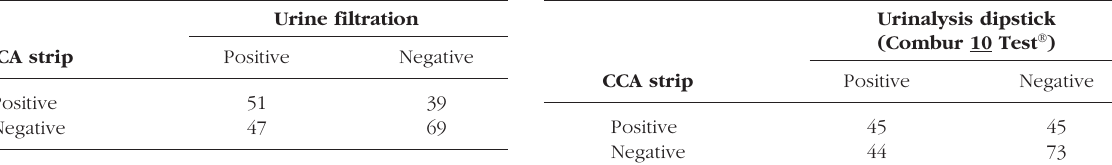
Table II. – Diagnostic performance of CCA strip compared with urine filtration for the diagnosis of urinary schistosomiasis in Hassoba Ele- mentary school, Afar, Ethiopia.